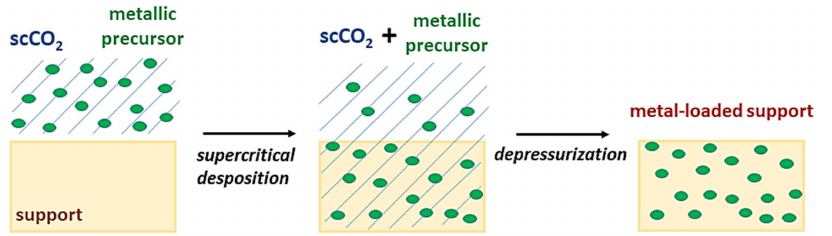
Figure 1. Sketch of supercritical deposition